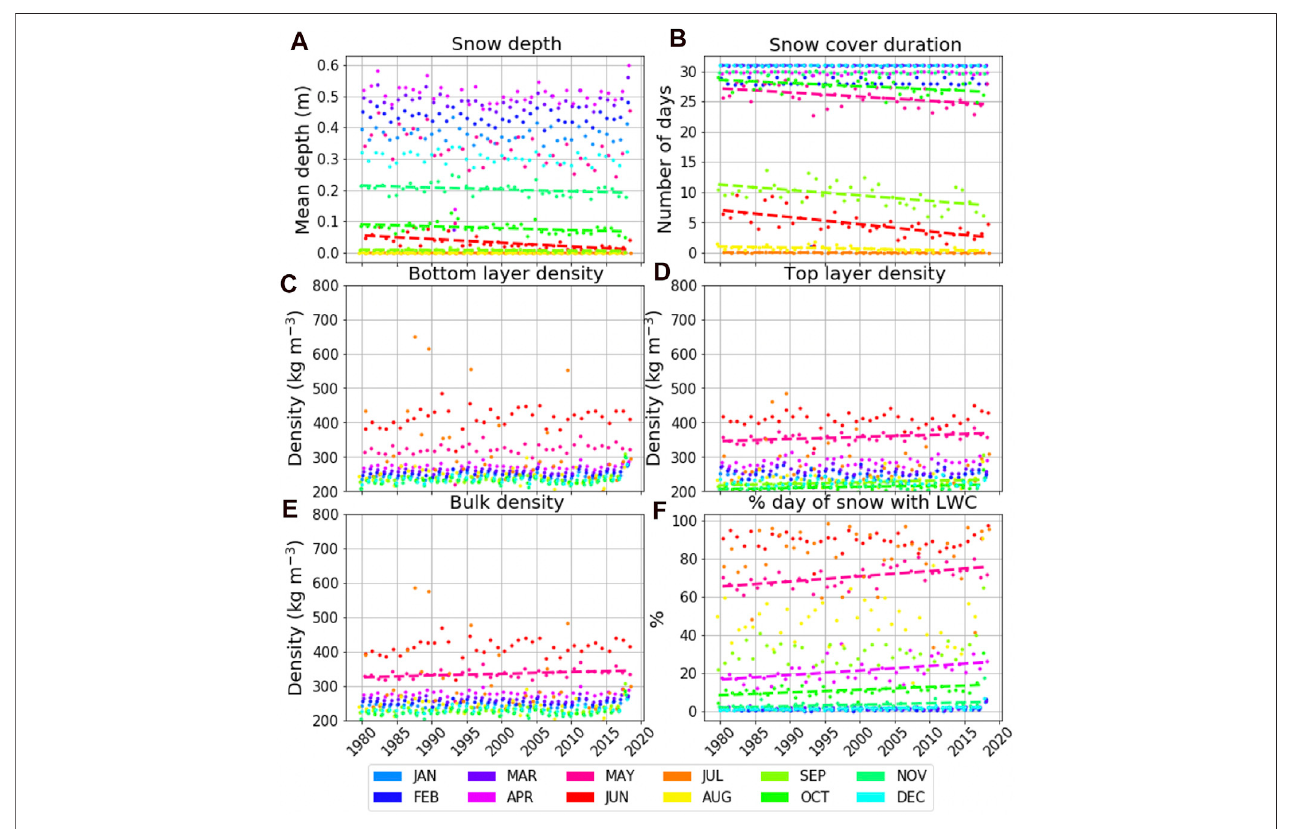
FIGURE6| Arctic-mean evolution ofsnow depth (A) ,snow cover duration (B) , bottom layer density (C) , top layerdensity (D) ,bulkdensity (E) , percentage ofdays with liquid water in snowpack (F) , for each month (colors) between August 1979 and July 2018. Linear regressions are plotted only for p -values lower than 0.05.